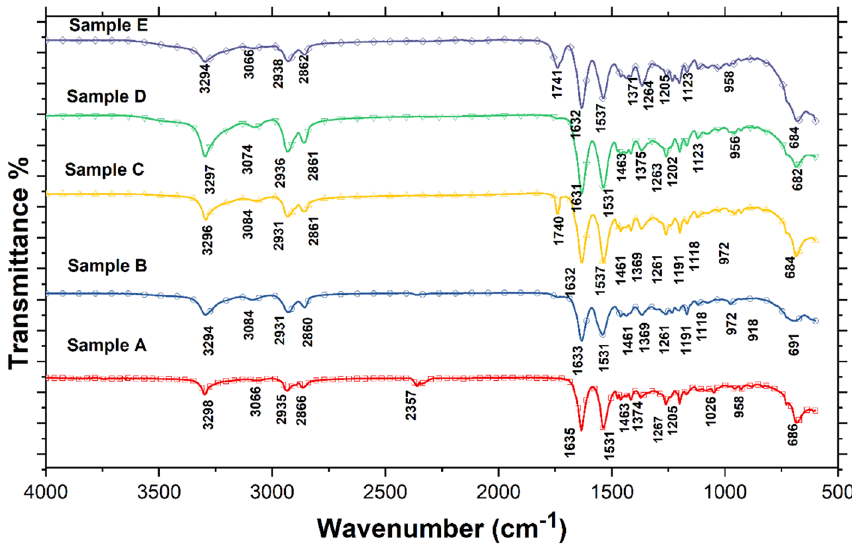
Figure 1. ATR-FTIR spectra of polymer and SHNMP composite